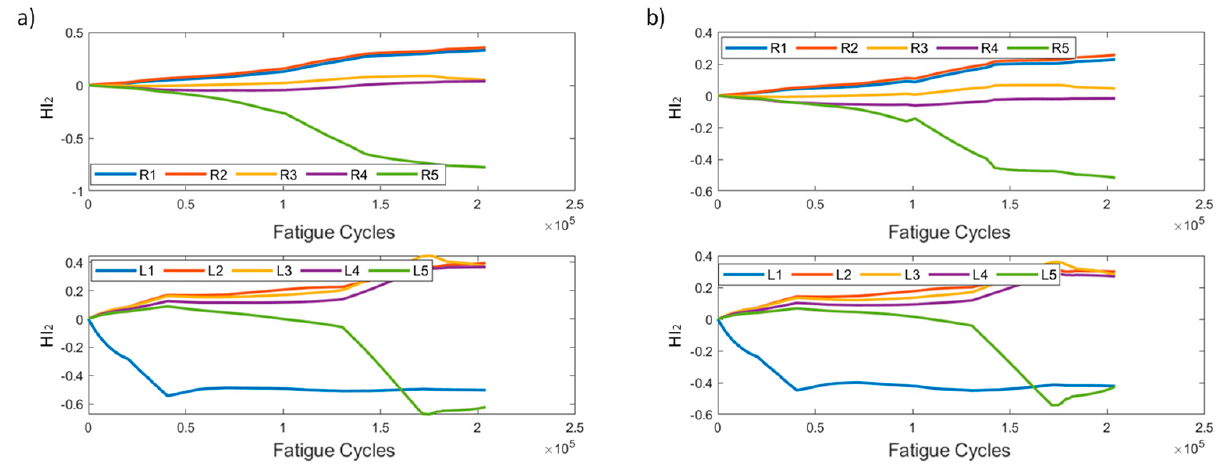
Figure 15. HI 2 progression through time for the two pre-processing methods for specimen VA-1: ( a ) method 1, ( b ) method 2.